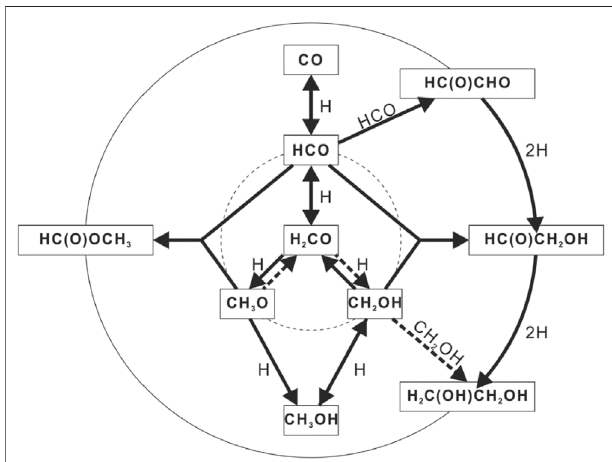
FIGURE 1 | Surface synthesis of glycolaldehyde, ethylene glycol, and possibly methyl formate at low temperatures, as studied by the Leiden group. Figure copied by permission of Oxford University Press from the article by Chuang et al. in Monthly Notices of the Royal Astronomical Society , vol. 455, page 702